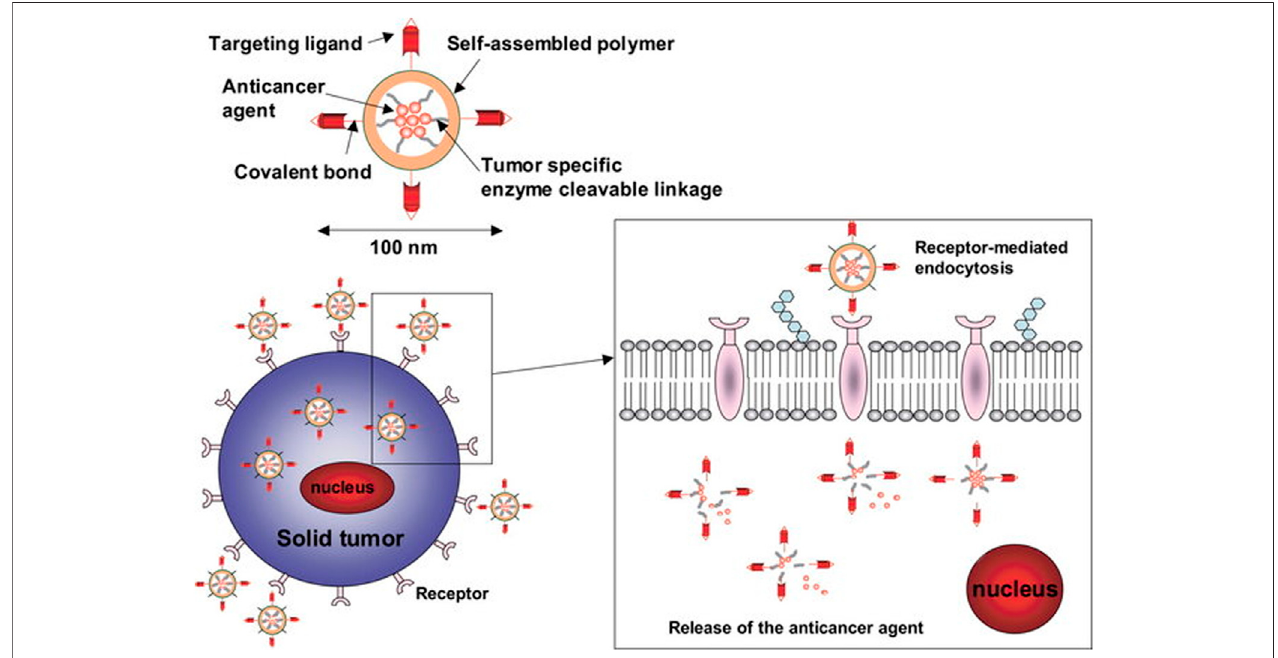
FIGURE 4 | Nanoparticles with ligands for targeted delivery bind to cell receptors to be internalized by receptor mediated endocytosis. Reproduced from Kim and Nie (2005) under Creative Commons Attribution (CC-BY) license (CC BY-NC-ND 3.0) (https://creativecommons.org/licenses/by-nc-nd/3.0/).